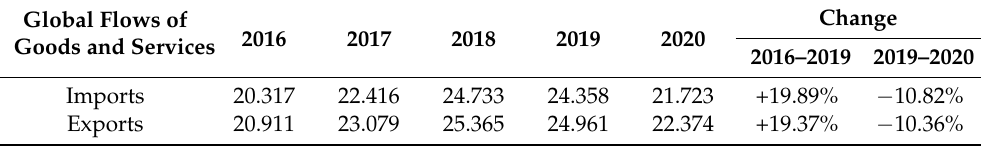
Table 1. Trends in global flows of goods and services, 2016–2020 (balance of payment in billions USD). Global Flows of Goods and